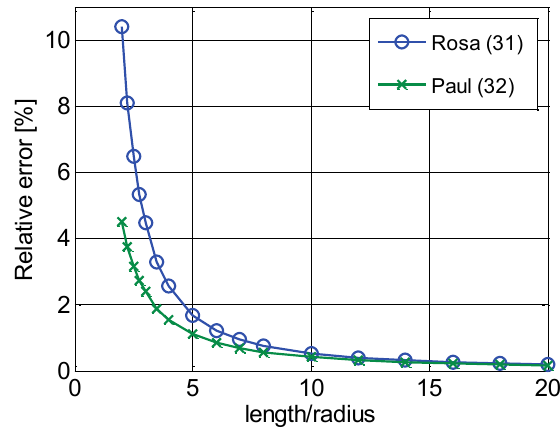
Figure 5: Relative errors of formulae (31) and (32) due to Rosa and Paul,